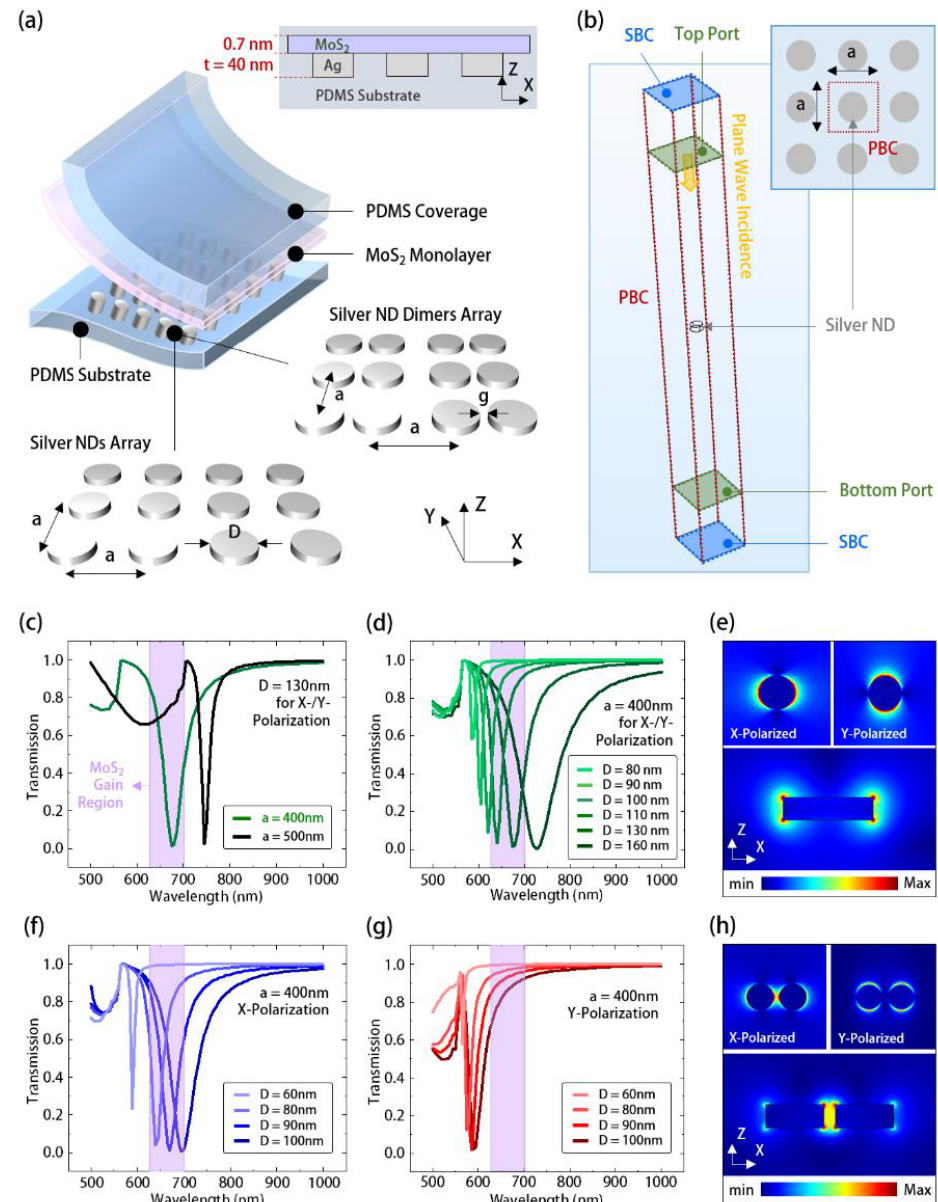
Figure 1. ( a ) Schematic and parameter definitions of silver ND and ND-dimer arrays covered with MoS 2 monolayer in PDMS; ( b ) the lattice unit cell in the 3D FEM setup for simulating transmission spectra of silver ND arrays in PDMS; theoretical transmission spectra of silver ND arrays with different ( c ) a and ( d ) D , where the purple shadows represent the gain region of MoS 2 ; ( e ) the electrical field distributions of the SLR mode along XY and XZ planes in silver ND array with D = 130 nm and a = 400 nm; theoretical transmission spectra of ( f ) X - and ( h ) Y -polarized SLR modes of silver ND-dimer array with different D values; ( g ) their electrical field distributions along XY and XZ planes under D = 100 nm, g = 20 nm, and a = 400 nm.